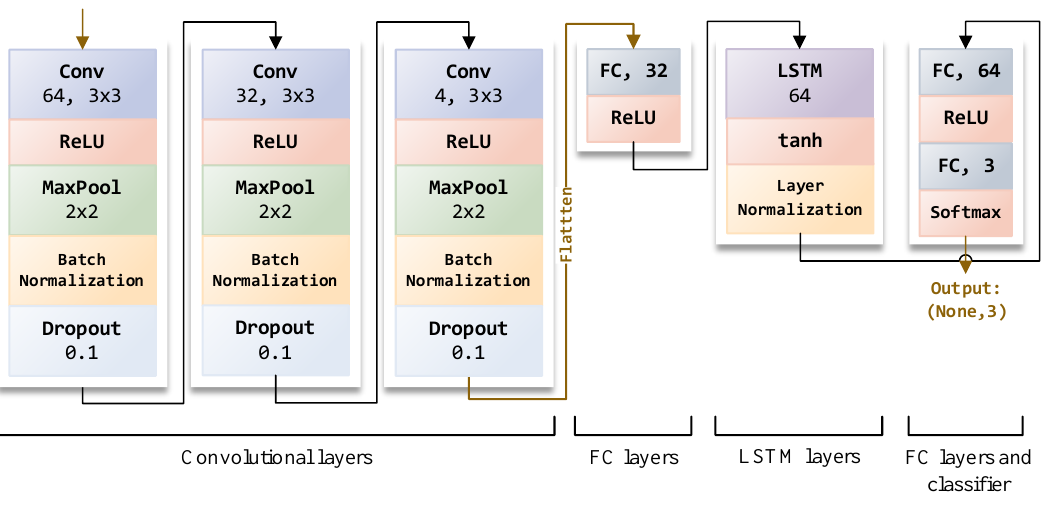
Figure 9. RCNN model design.